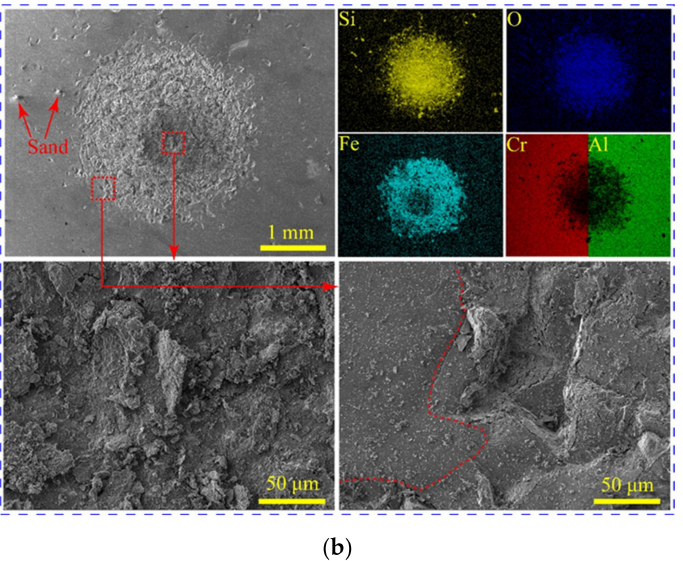
Figure 12. SEMmicrographofimpactwearscarsat500 ◦ Cwithsand. ( a )CrNcoating,and( b )CrAlN coating. Figure 13 present the SEM image of the cross-section of wear scar and element distribu-